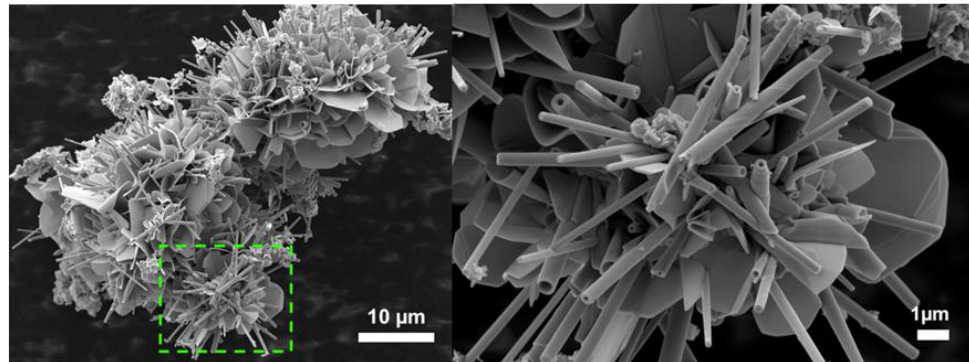
Figure 2. SEM images (two different magnifications) of La x Sr 1− x S-TaS 2 powder prepared from 10 atom % Sr (90 atom % La) in the precursor. Tubular structures and conical nanoscrolls along with sheet-like morphology (flakes) are visible (adopted from [27] ).